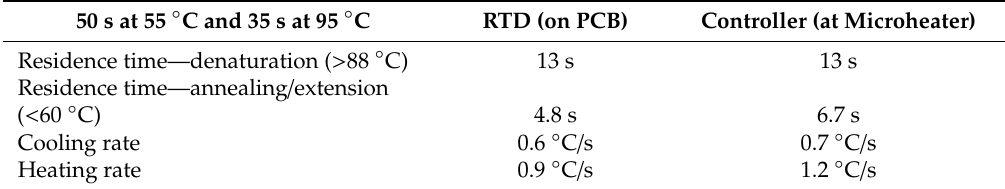
Table 3. Residence time and ramping rates for the thin PCB microheater chip .